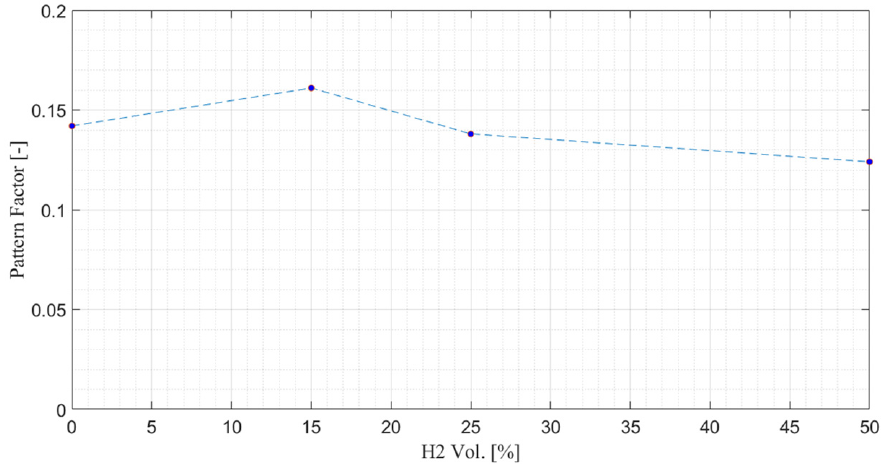
Figure 17. Pattern factor as a function of the fuel hydrogen content.